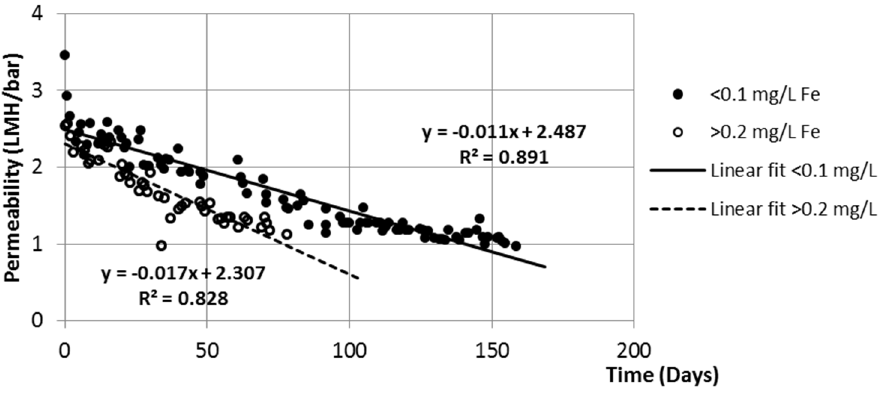
Figure 7. Relationship between permeability with 100 µg/L and 200 µg/L dissolved iron and time (LMH = L·m −2 ·h −1 ).